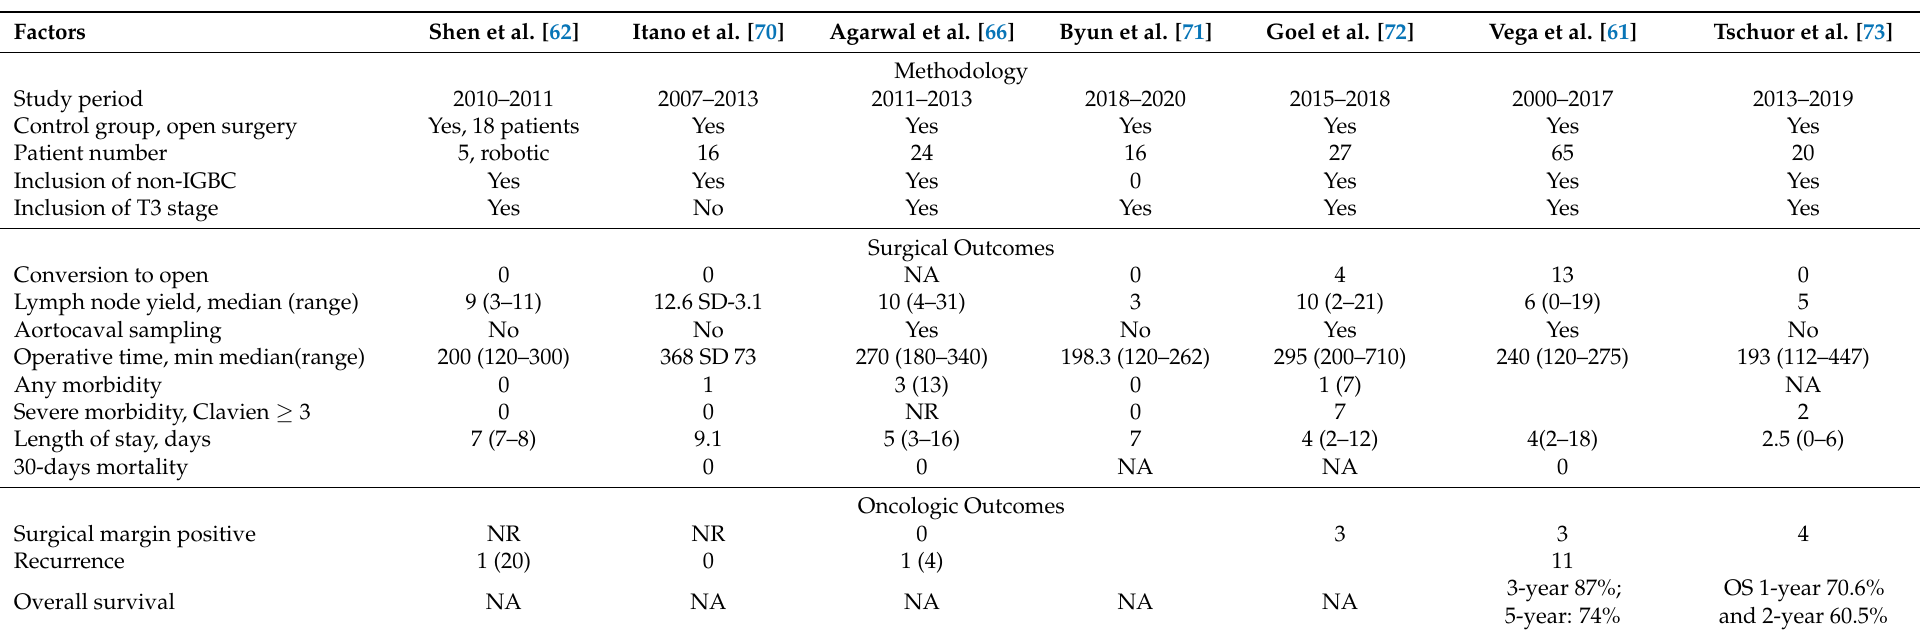
Table 1. Minimally invasive oncologic extended resection series to date with control